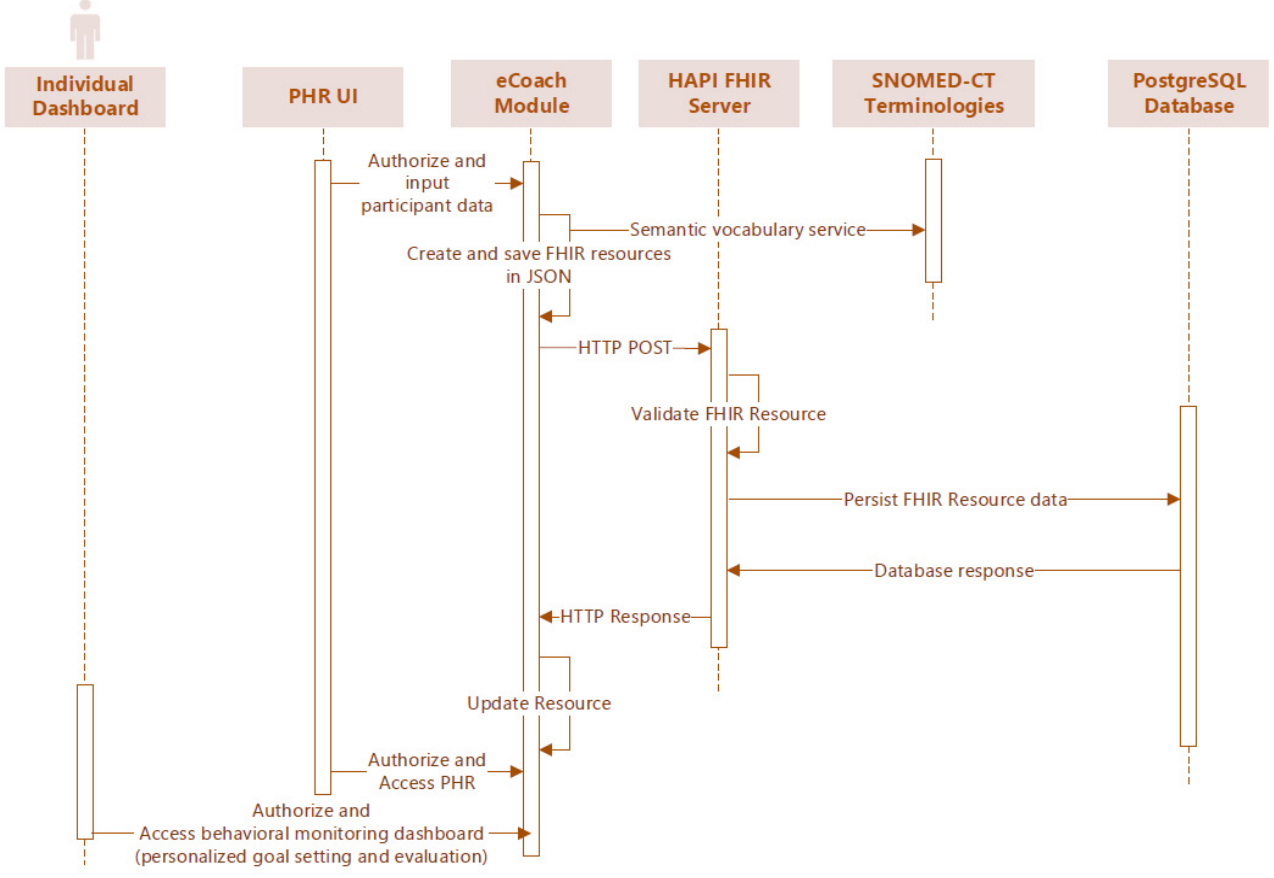
Figure 4. Sequence diagram to synchronize data from PHR (eCoach) with EHR (TSD PostgreSQL).